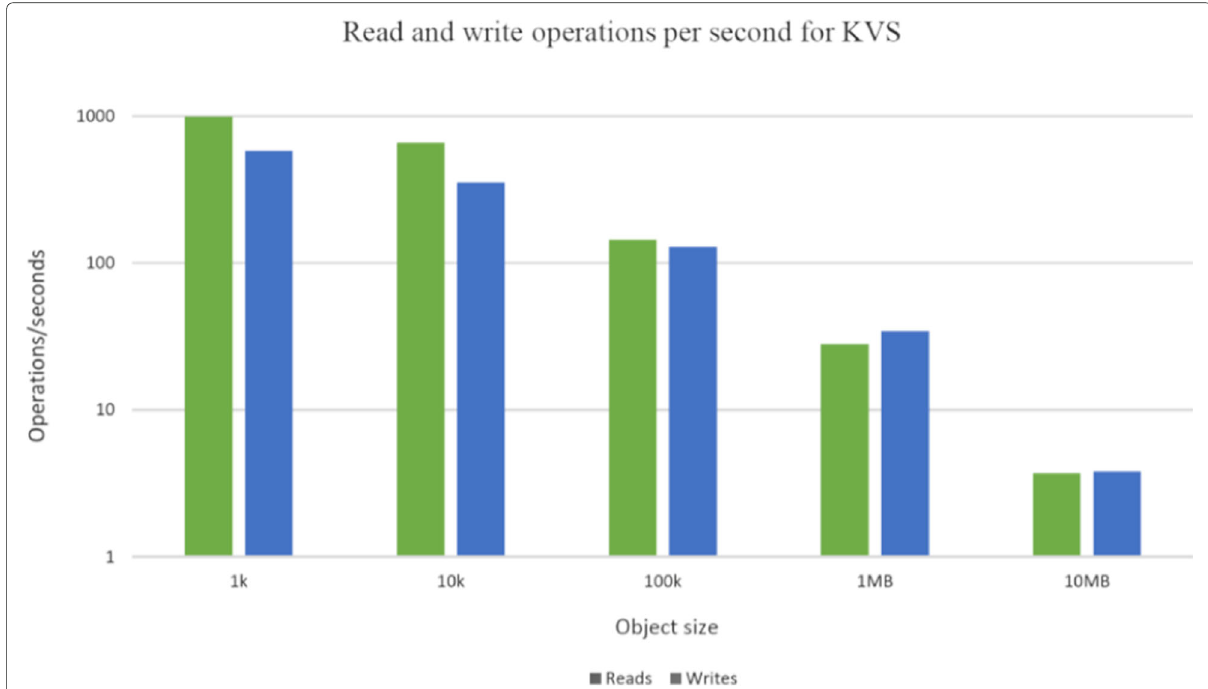
Fig. 6 Secure KVS: read and write operations for different object